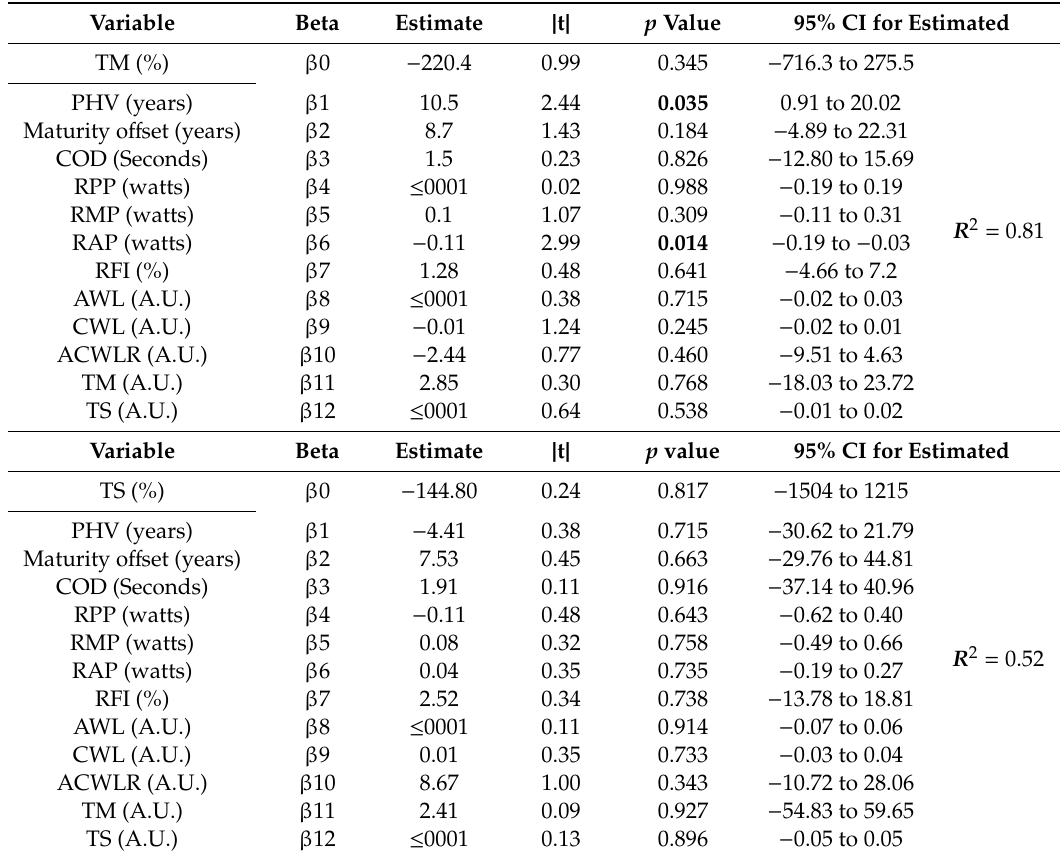
Table 5. Multiple linear regression analysis: percentage of change between EaS and EnS in TM and TS with workload parameters, baseline fitness levels, and PHV. Variable Beta Estimate | t